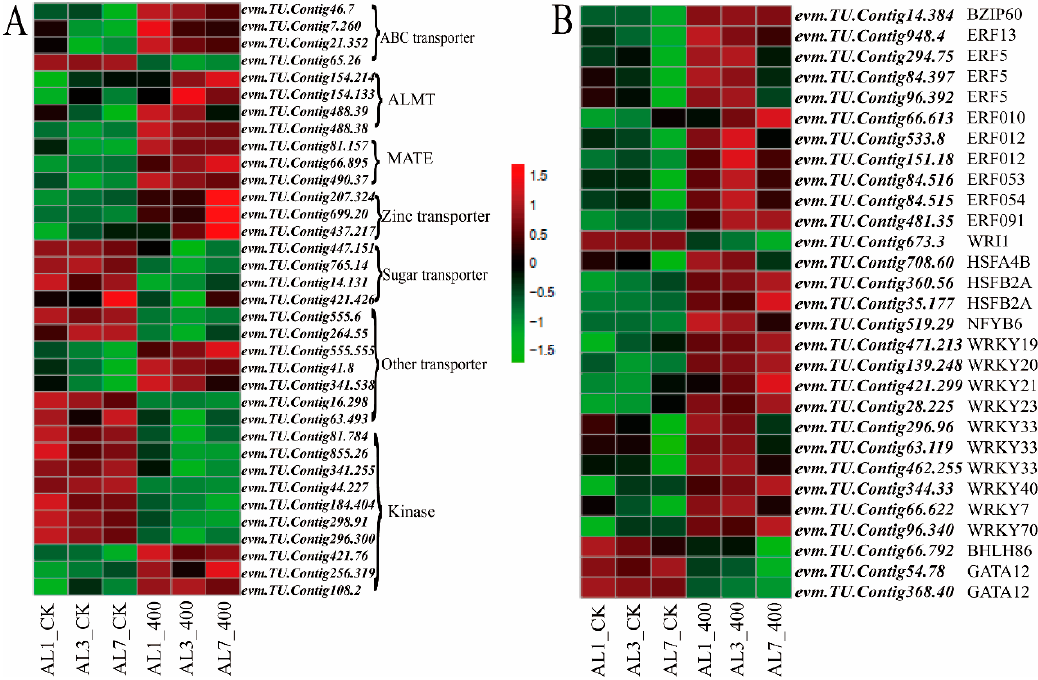
Figure 10. Expression of related transporters and transcription factors induced by aluminum stress.